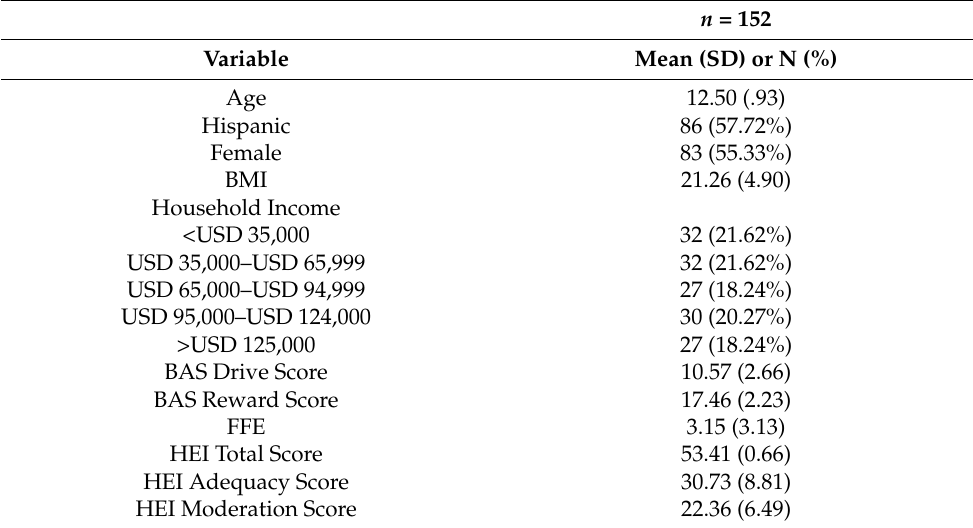
Table 1. Participant demographics and descriptive statistics of study variables.